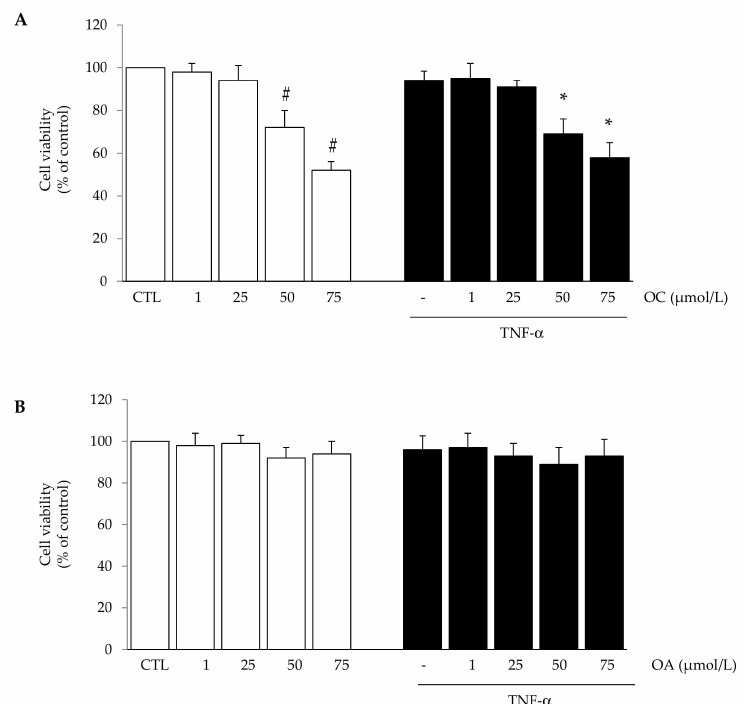
Figure 1. The e ff ect of oleocanthal (OC) and oleacein (OA) treatment on cell viability. Simpson-Golabi- Behmel syndrome (SGBS) adipocytes were treated with OC ( A ) or OA ( B ) for 6 h at the concentrations indicated, and then either treated with 10 ng / mL TNF α (black filled bars), or left untreated (open white bars), for 18 h. Cell viability was assessed by the 3(4,5dimethylthiazolyl)-2,5-diphenyl-tetrazolium bromide (MTT) assay, and expressed as percent of unstimulated control (CTL). Data are means ± SD (n = 3). # p < 0.05 versus CTL. * p < 0.05 versus TNF- α alone.